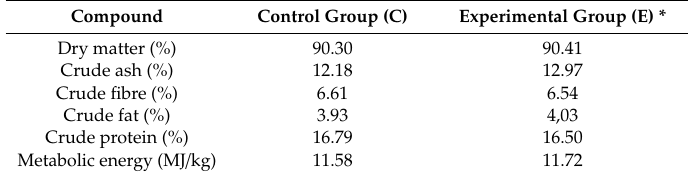
Table 1. Nutrient composition of feed mixtures from both groups.